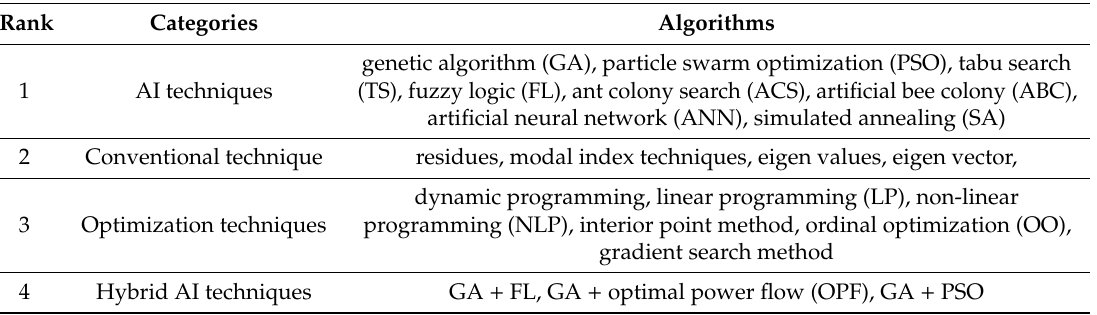
Table 2. Categories of various optimization algorithms